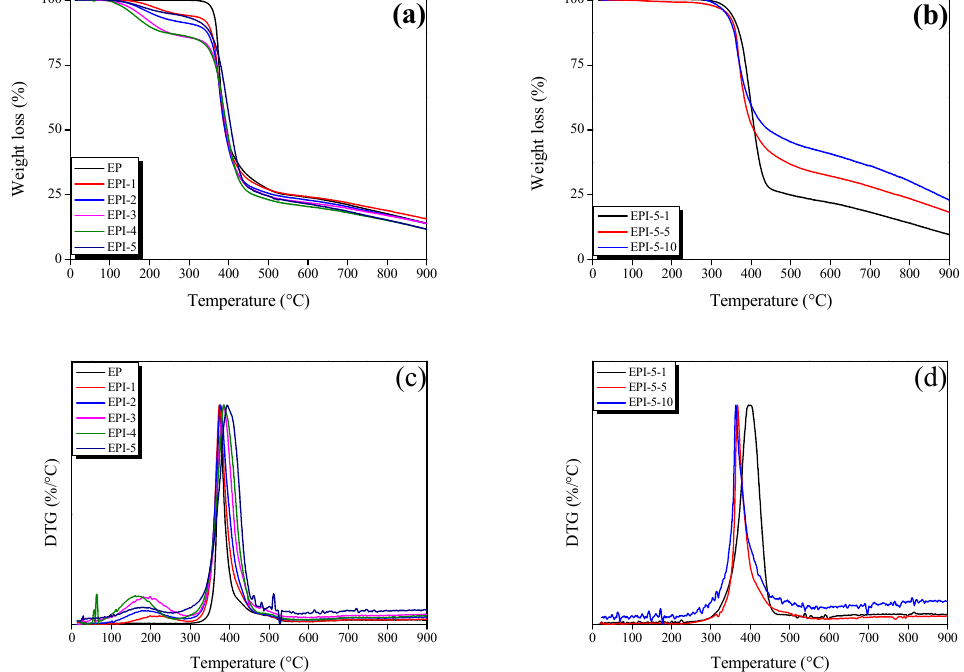
Figure 5. Thermogravimetric analysis (TGA) and DTG thermograms of cured epoxy/polyimide blends analyzed as a function of polyimide content in N 2 gas atmosphere; ( a , c ) cured EPI and ( b , d ) postcured